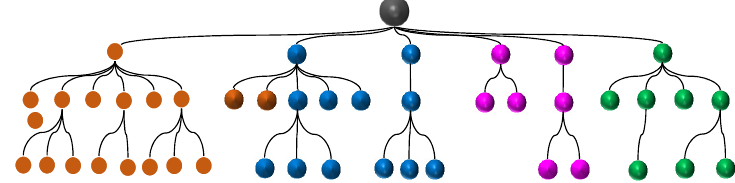
Figure A9. The architecture of Classification and Regression Trees.